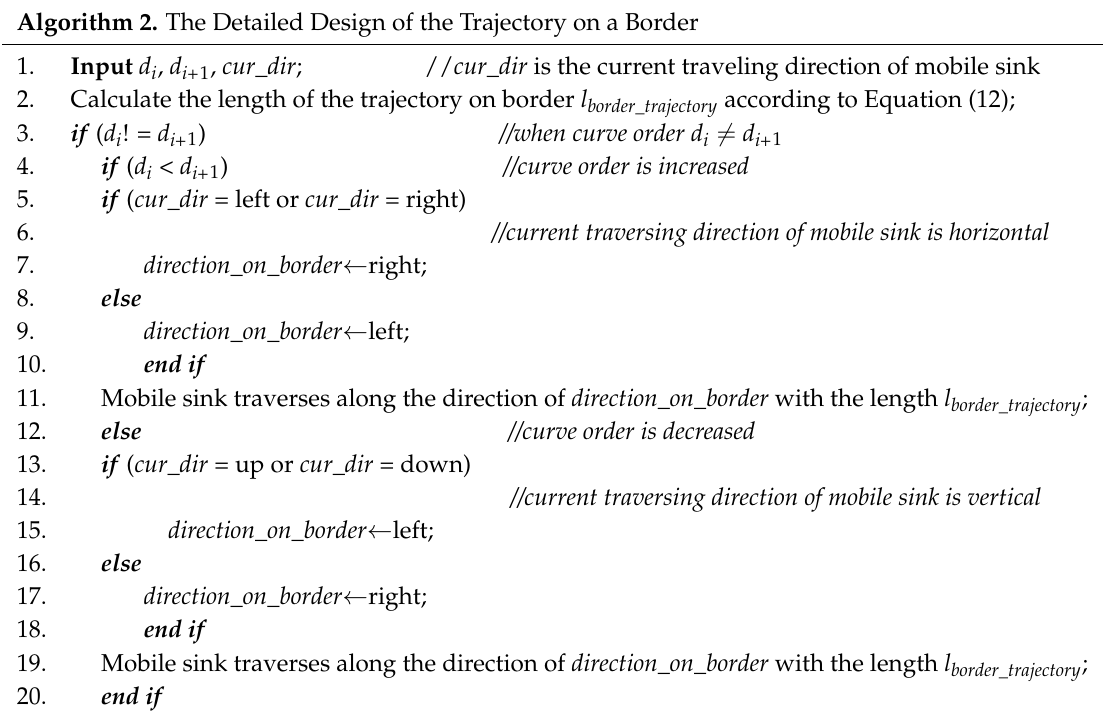
Algorithm 2. The Detailed Design of the Trajectory on a